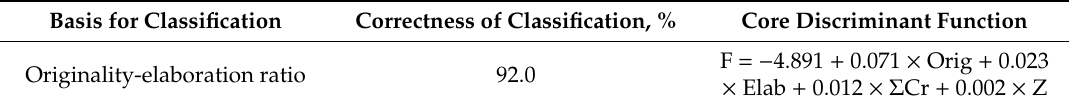
Table 2. Findings of discriminant analysis.